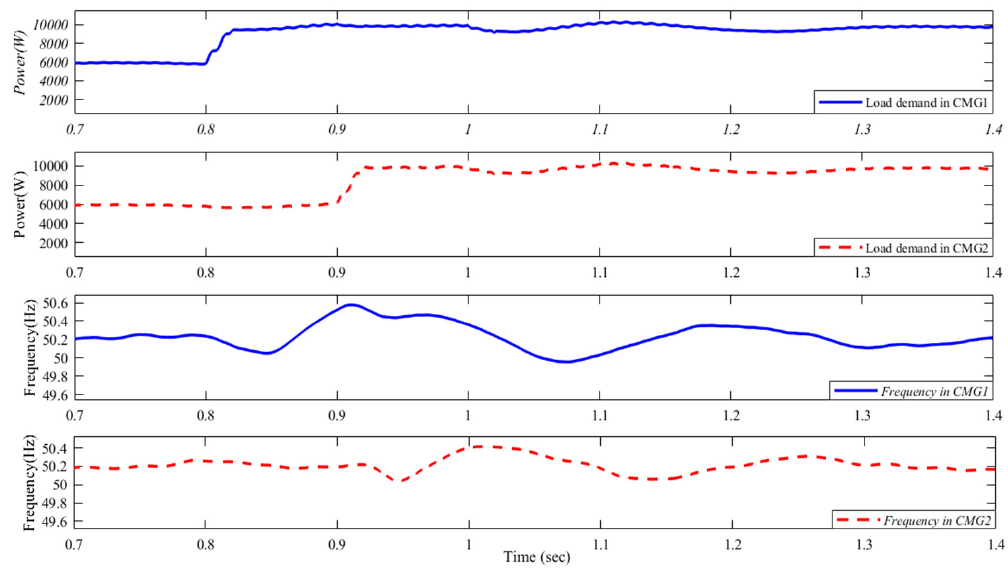
Figure 6. System parameters for isolated operation of CMG 1 and CMG2.